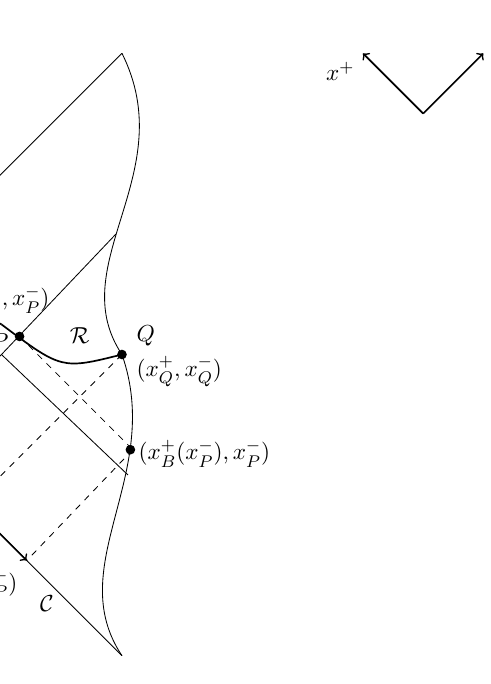
Figure 1 . Entanglement of matter (cid:12)elds across the